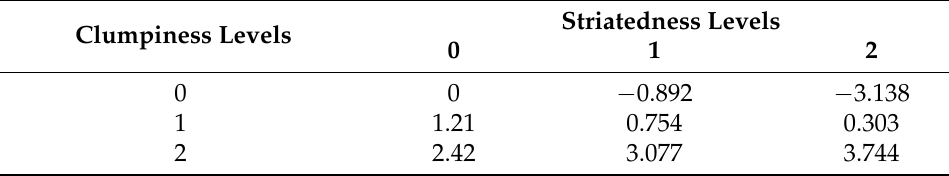
Table A3. Interaction Log odds of Clumpiness &